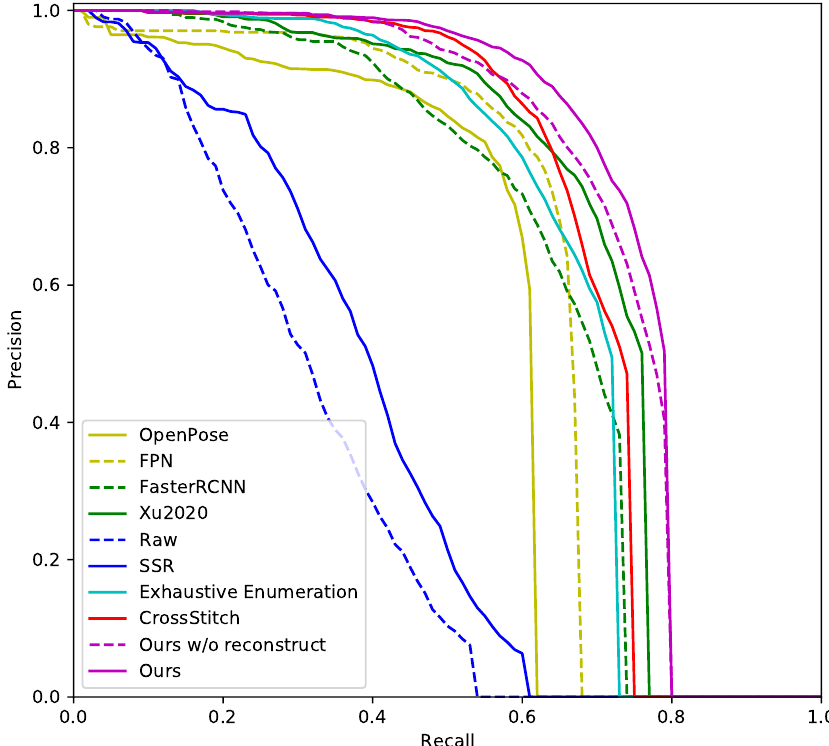
Figure 7. The precision recall curve of the compared